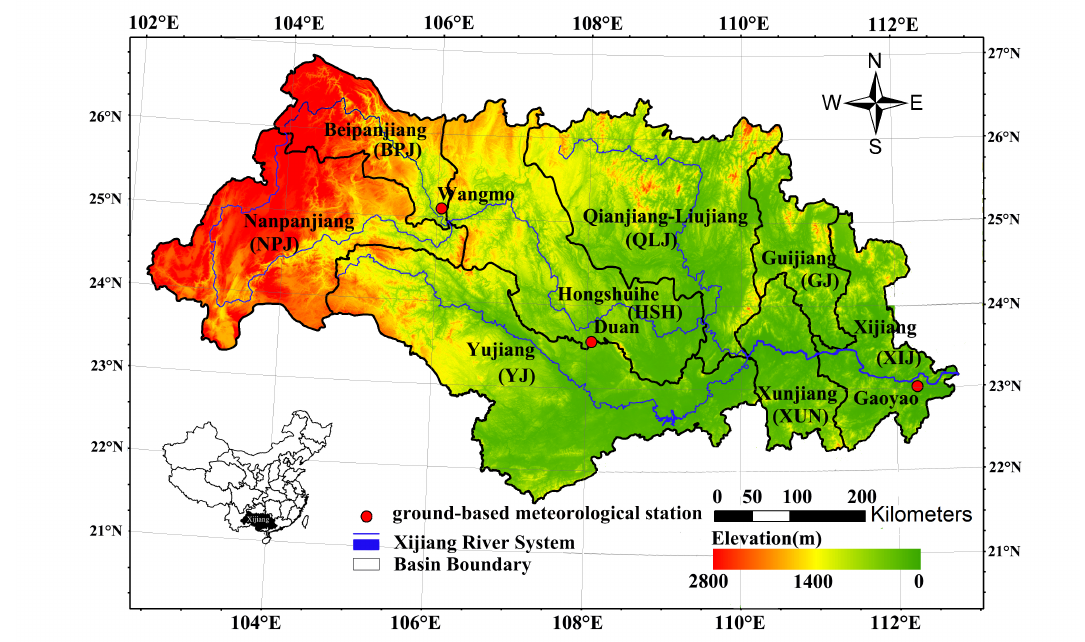
Figure 1. Regional map showing the location of three ground-based meteorological stations (red dots), the Xijiang River System (blue), and the local topography (elevation in metre) of the Xijiang Basin. The geographical location of the study region within China is shown in the small inset map (bottom left).